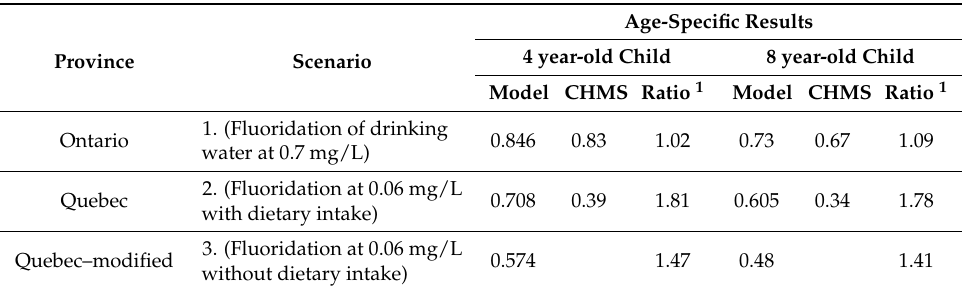
Table 3. Urinary fluoride concentrations (mg/L) modeled in a 4-year-old and an 8-year-old child for different exposure scenarios compared with Province-specific CHMS biomonitoring data.